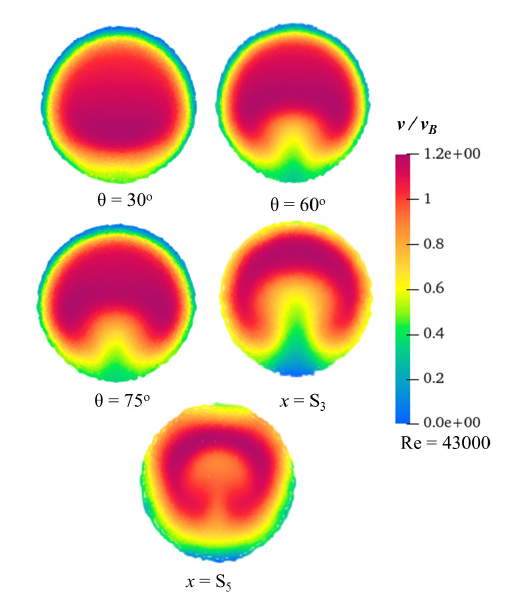
Figure 9. Cross-sectional streamwise velocity maps at planes θ = 30 ◦ , 60 ◦ and 75 ◦ in the bend and at stations S 3 = 1 D and S 5 = 6 D downstream of the bend outlet for Re = 43,000. The numbers on the color bars indicate the values of the streamwise velocity normalized to v B .